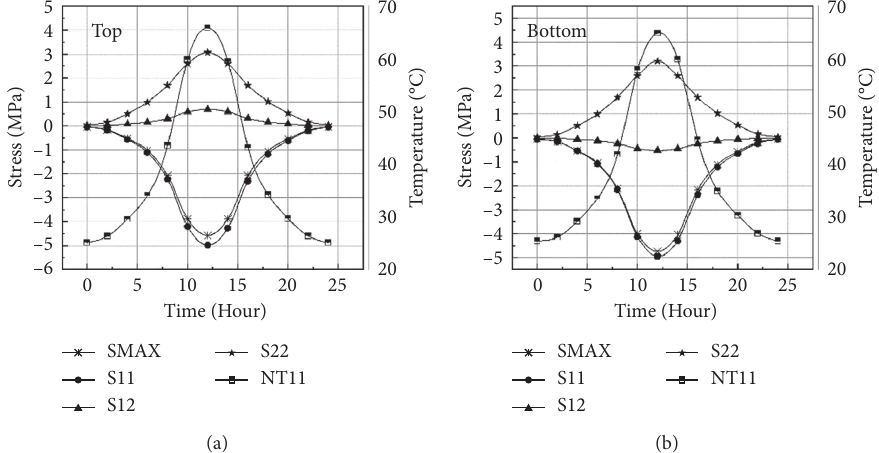
Figure 8: Time-history response curve of stresses above void area in the “void” condition in the summer: (a) slab top and (b) slab